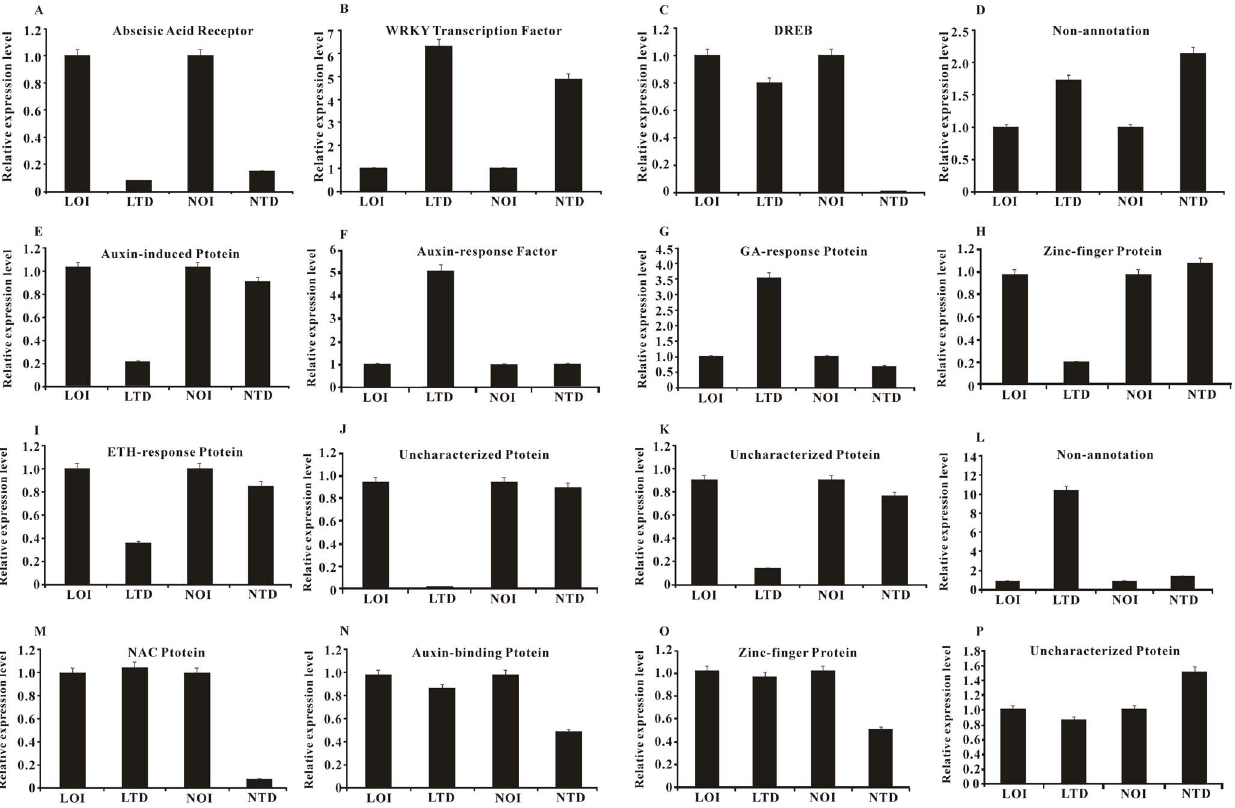
Figure 4. Relative expression levels of 16 DEGs. The relative gene expression levels as expressed by 2 2 gg CT were determined separately for each treatment as the mean 6 S. A, comp13117_c0_seq1 ; B, comp19490_c0_seq1 ; C, comp18282_c0_seq1 ; D, comp40404_c0_seq1 ; E, comp18253_c0_- seq1 ; F, comp18888_c3_seq1 ; G, comp18293_c0_seq1 ; H, comp19585_c0_seq1 ; I, comp16965_c0_seq1 ; J, comp40354_c0_seq1 ; K, comp19389_c0_seq1 ; L, comp38170_c0_seq1 ; M, comp11891_c1_seq1 ; N, comp18632_c0_seq1 ; O, comp19229_c0_seq1 ; P, comp18242_c0_seq1